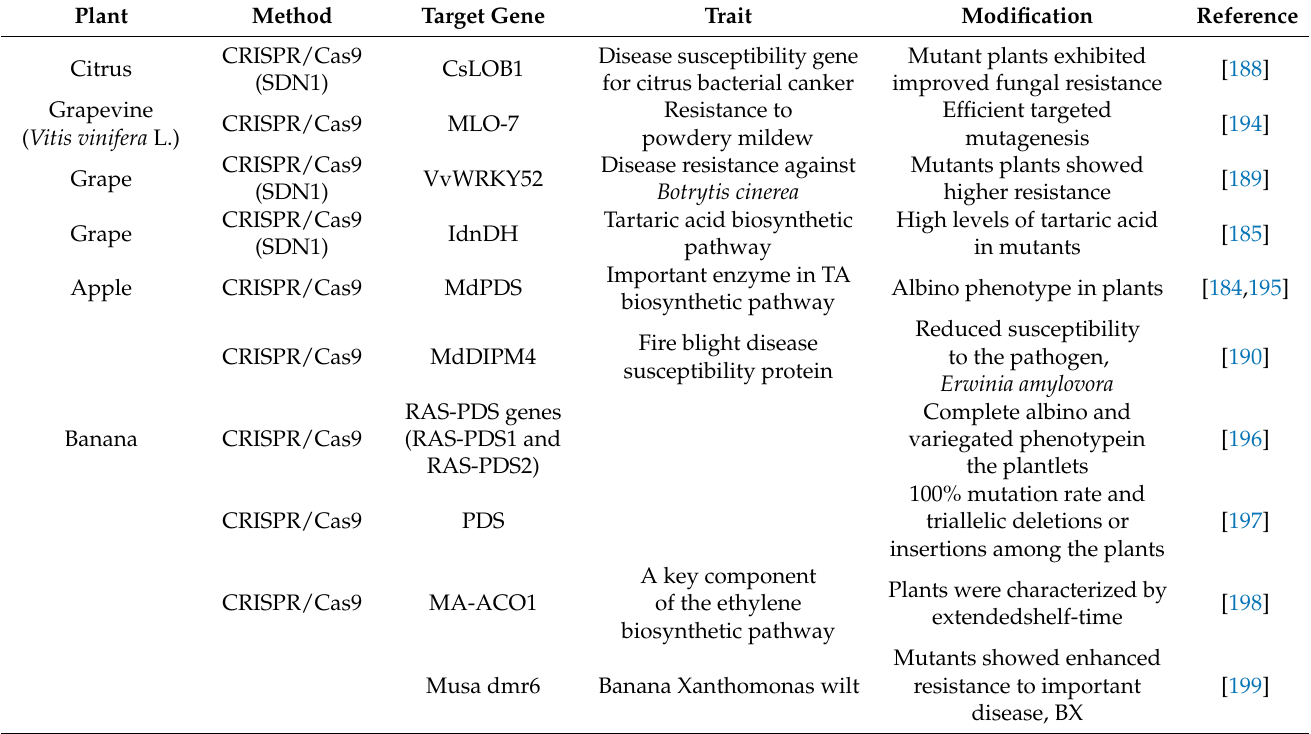
Table 3. Successful examples of genome editing in fruit